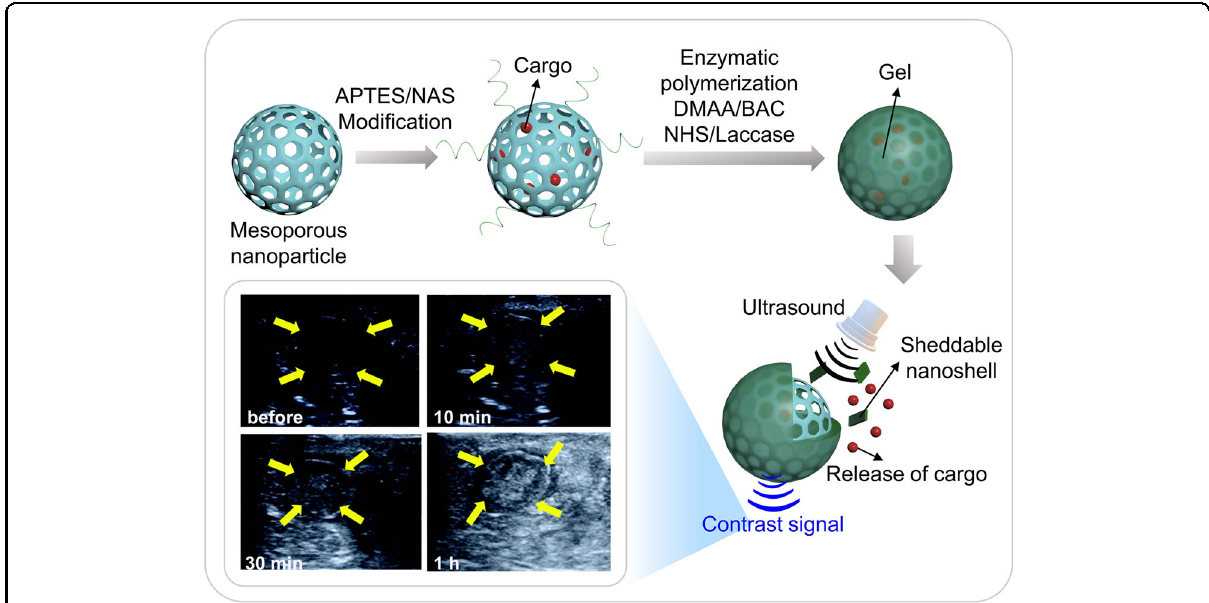
Fig. 13 Mesoporous nanoparticle-based ultrasound-responsive delivery system for drug delivery. Adapted with permission from [197], copyright 2016 Royal Society of